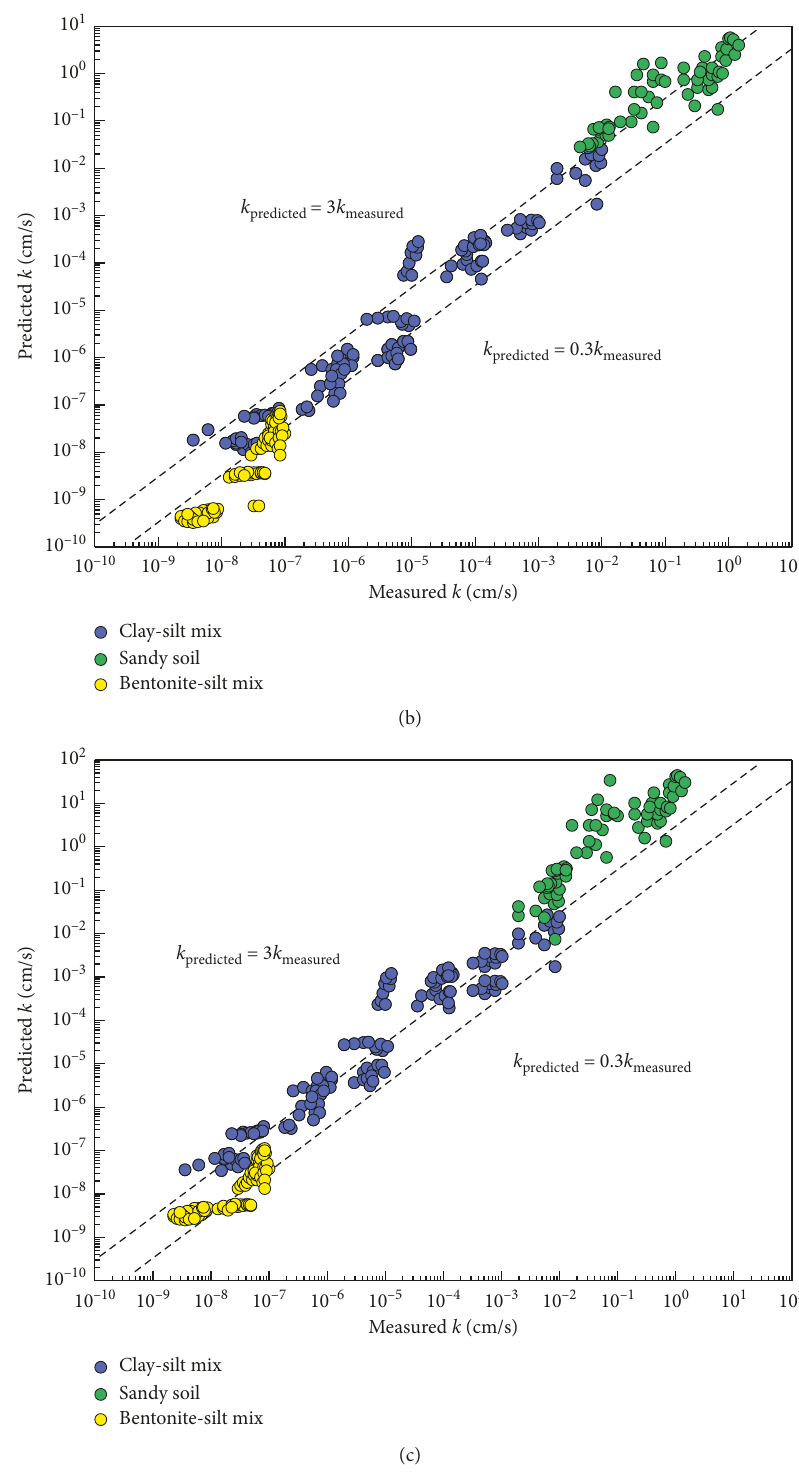
Figure 19: The measured hydraulic conductivity k versus the predicted k by equation (23) for three different types of soil: (a) three-particle system; (b) four-particle system; (c) five-particle system. Data source: [9, 61,